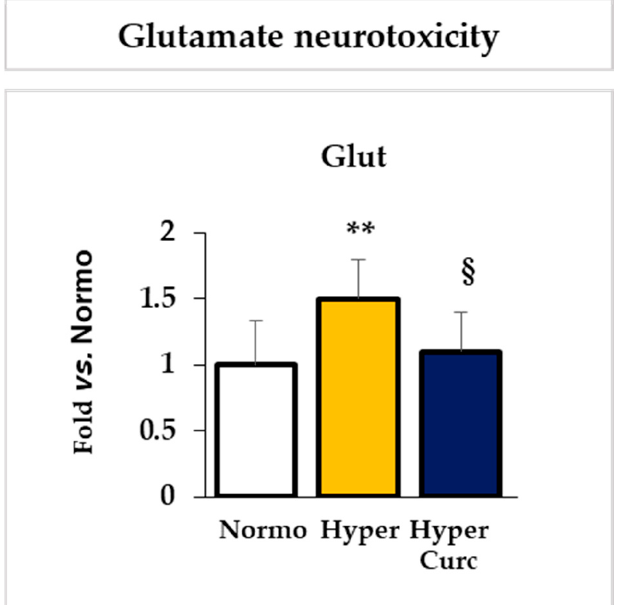
Figure 6. Curc prevents the increase of glutamate in the Hyper Gunn rat. The effect of Curc on the glutamate content in the Cll of hyperbilirubinemic pups was quantified by an enzymatic test. With white bars—untreated normobilirubinemic (Normo) Gunn pups; yellow bars—untreated hyperbilirubinemic rats (Hyper); blue bars—curcumin-treated hyperbilirubinemic pups (Hyper Curc). Data are in mean ± S.D. and expressed as fold vs. the Normo pups used as reference (=1). In each experimental group, ≥ 6 animals were studied. Statistical significance was evaluated by the one-way analysis of variance (ANOVA), followed by a Tukey–Kramer Multiple Comparisons Test when p -value < 0.05. Statistical significance: **: p < 0.01 vs. Normo pups. § p < 0.05 vs. Hyper rats.